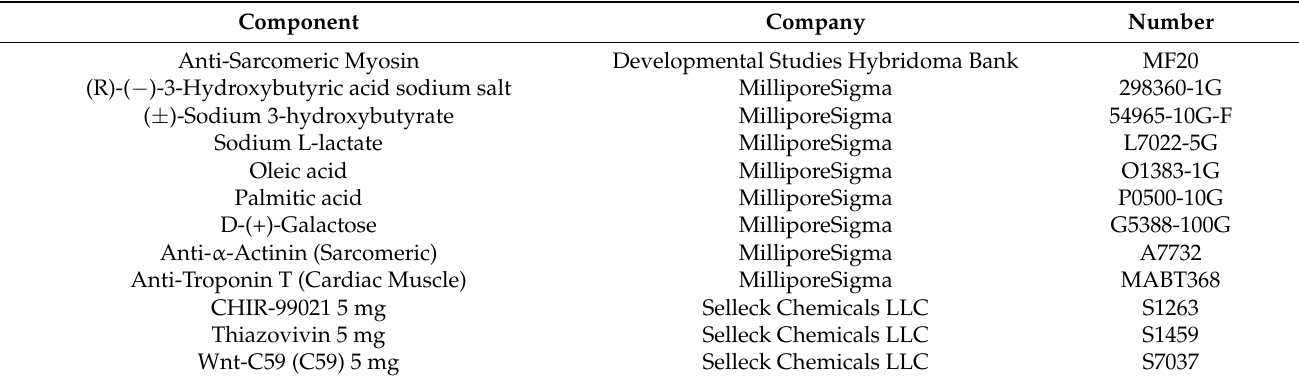
Table 1. List of special reagents used for this